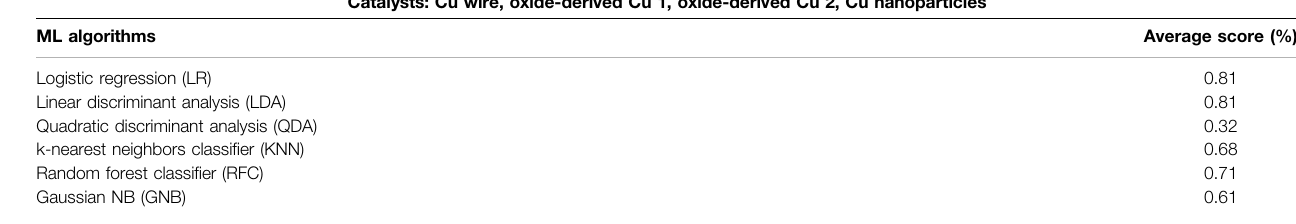
TABLE 2 | The results of cross-validation with six different classi fi cation algorithms against low-temperature catalyst types in four classes (Cu wire, Oxide-derived Cu 1, Oxide-derived Cu 2, Cu